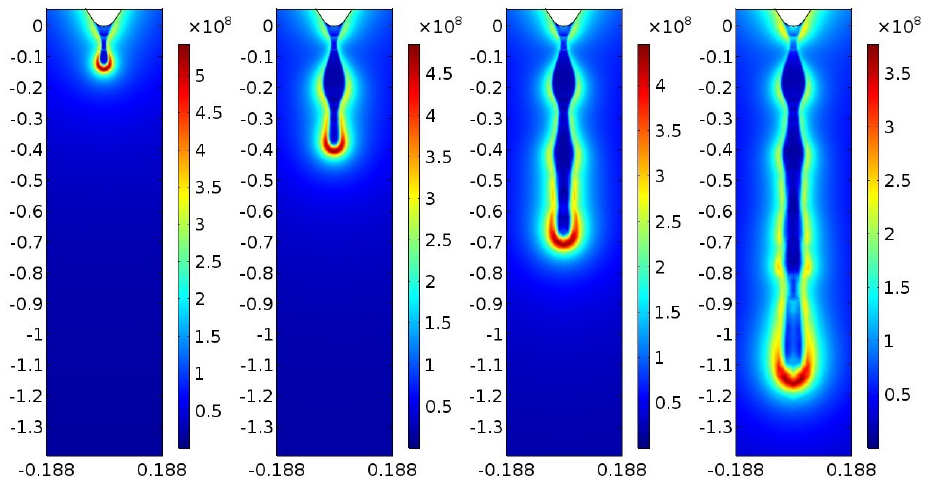
Figure 3. Positive streamer propagation. Evolution of the electric field ( V/m ) in mineral transformer oil along the z -axis, applying 300 kV and with a rise time of 10 ns.